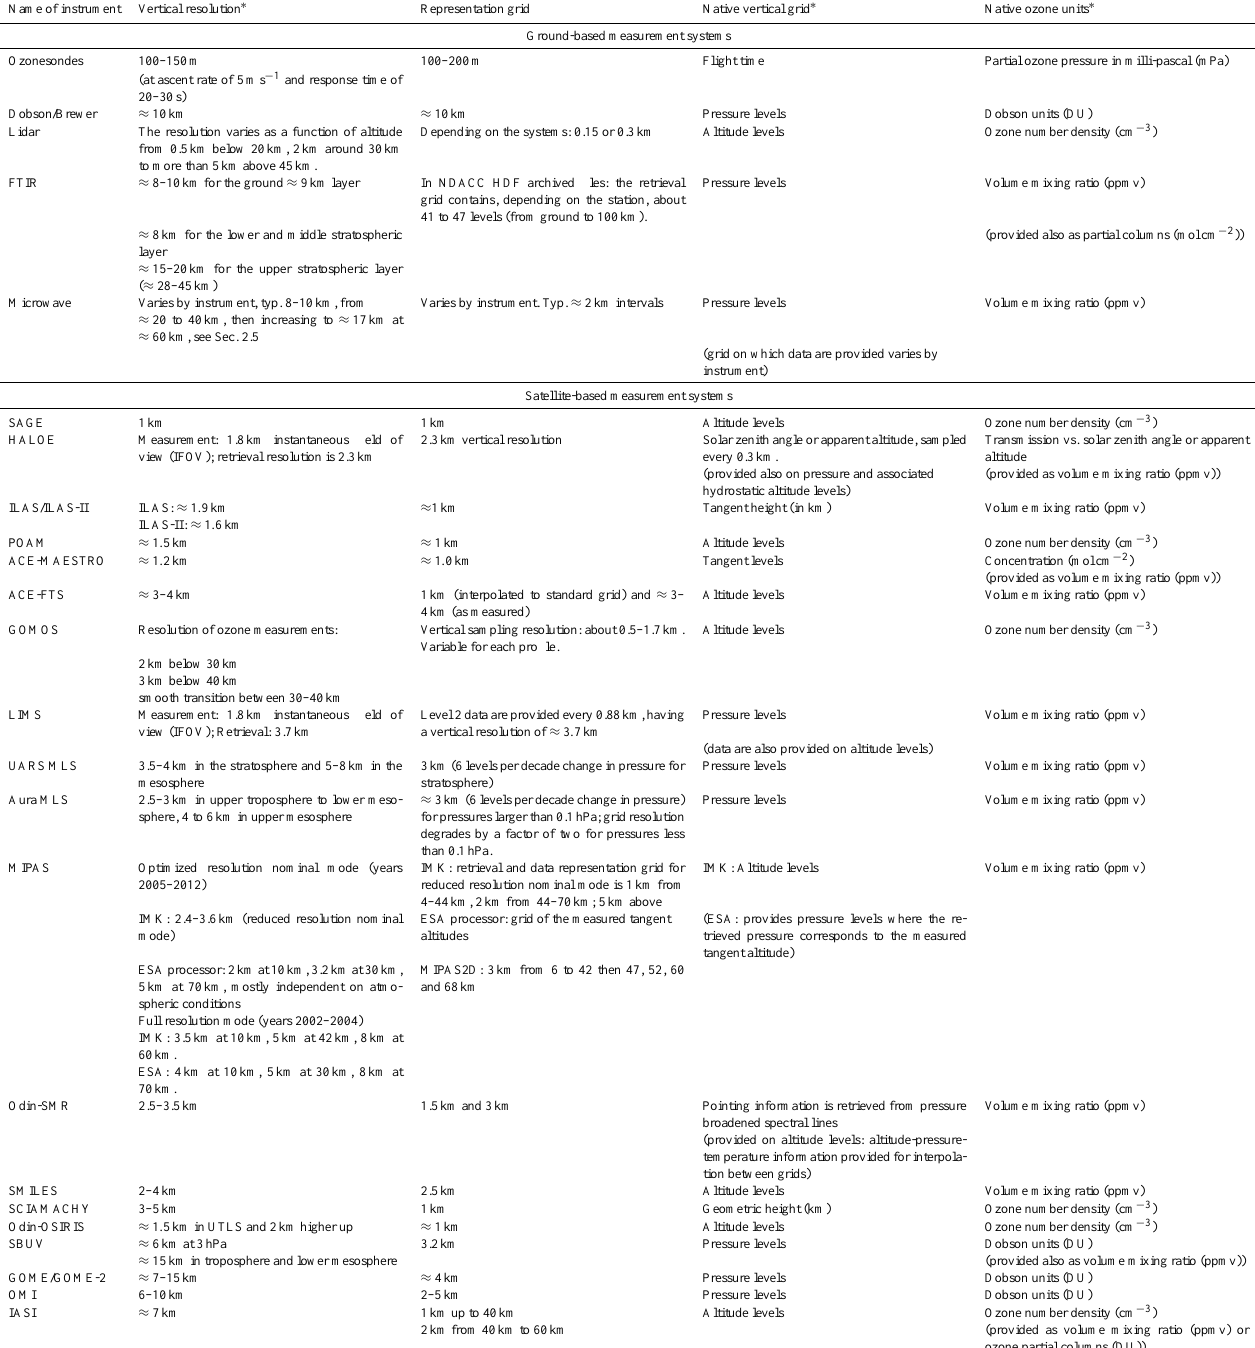
Table 1b. Summary of the vertical resolution, native vertical grid and native ozone units for the five ground-based measurement systems and all described satellite measurement